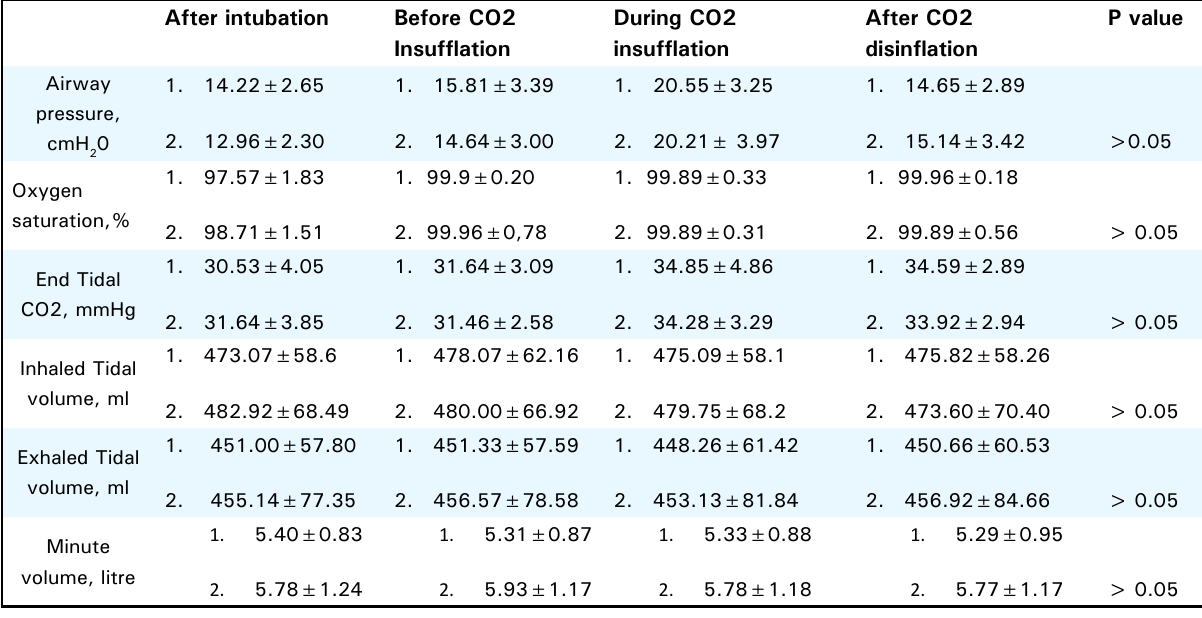
Table 2. Airway pressure, oxygen saturation, End tidal CO in two groups, 1: Tracheal tube group, 2: I gel